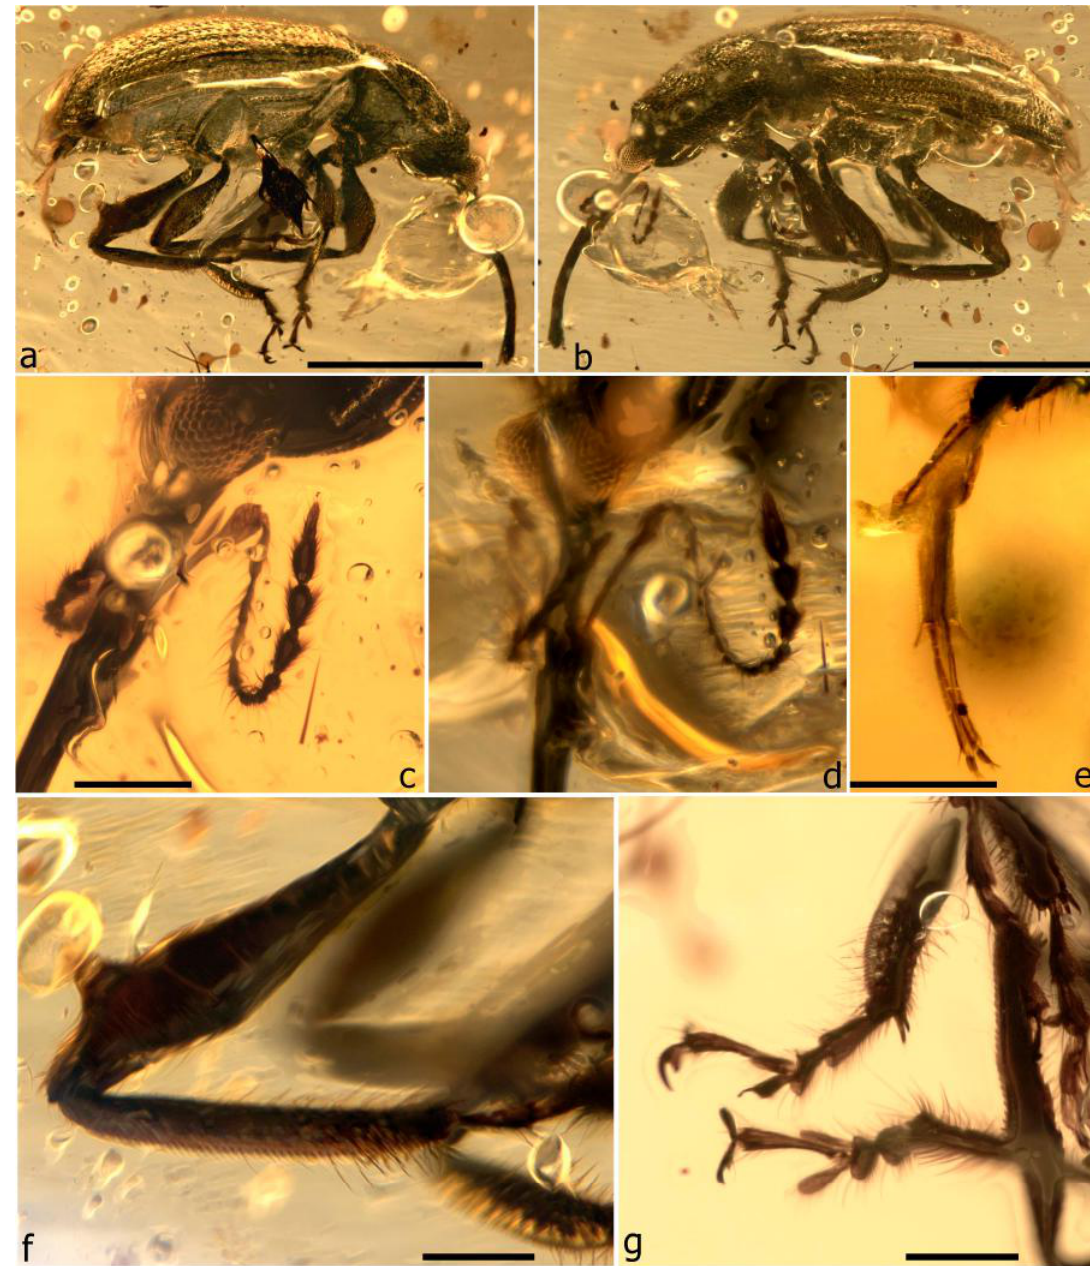
Figure 84. Bowangius sp. 2. Habitus, right lateral ( a ); left lateral ( b ); head and antenna, left lateral ( c ); same ( d ); ovipositor ( e ); left hindleg, posterior ( f ); tarsi ( g ). Scale bars: 1.0 mm (a,b); 0.2 mm (c,e–g).